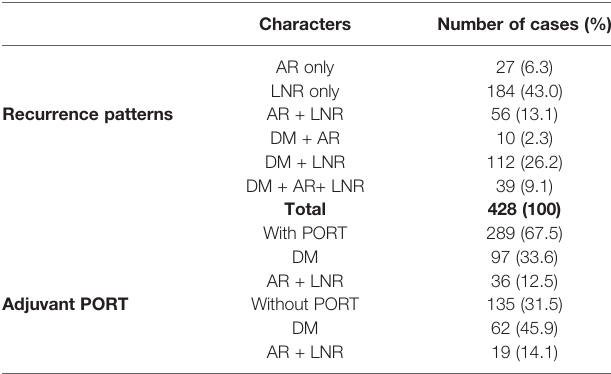
TABLE 1 | Recurrence patterns and adjuvant PORT of the 428 patients with ESCC after radical surgery. Characters Number of cases (%) AR only